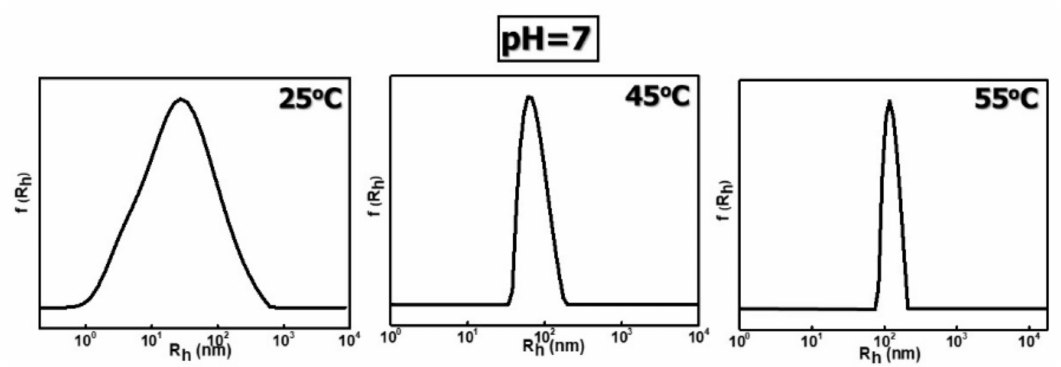
Figure 4. Hydrodynamic radius distributions from Contin analysis for the PDMAEA 20 -b-PNIPAM 11 -b- POEGA 18 triblock terpolymer in aqueous solutions at neutral pH and at selected temperatures (at an angle of 90 ◦ ).